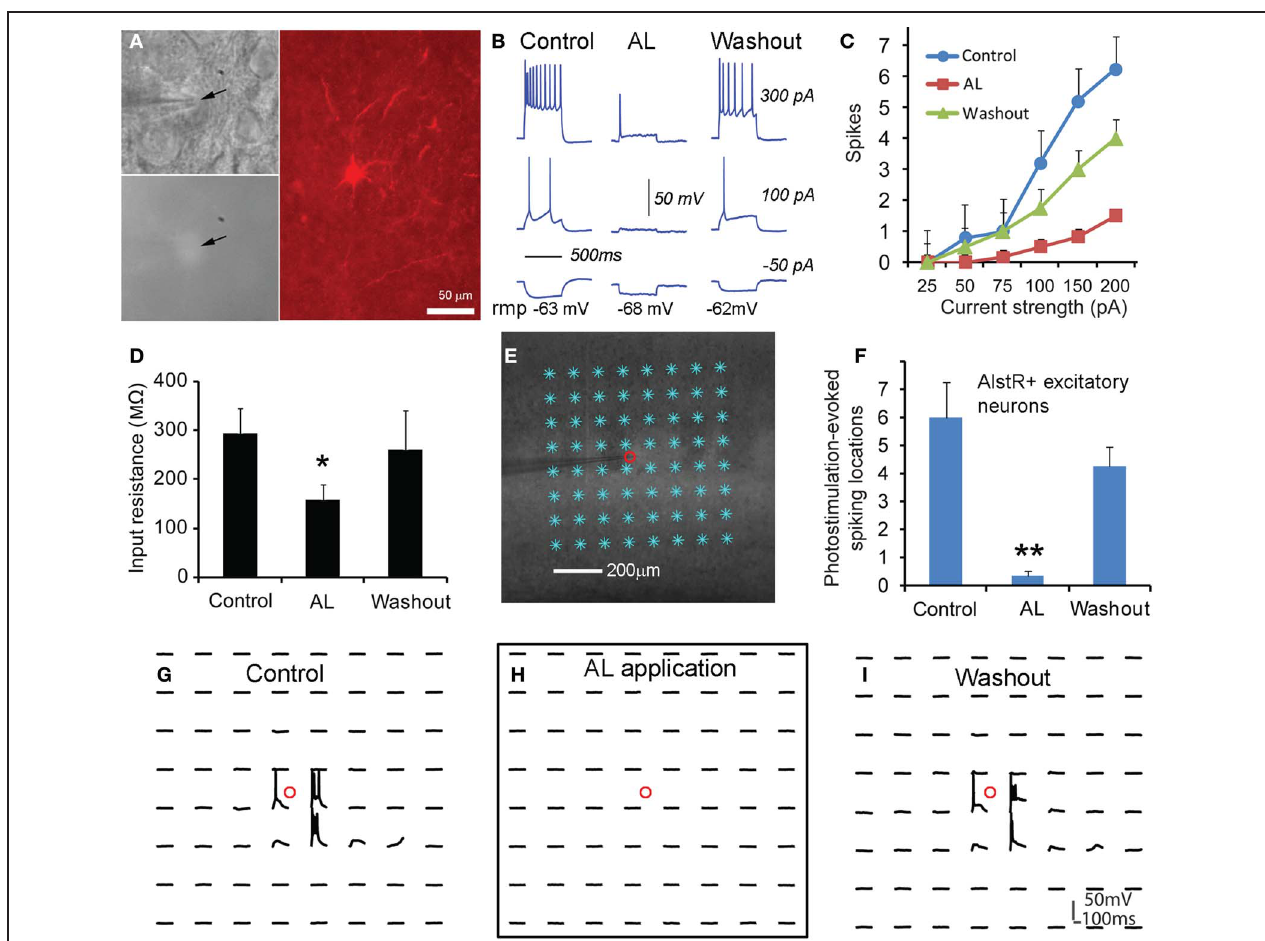
FIGURE 2 | Excitatory neuronal inactivation through the AlstR system. (A) One recorded excitatory neuron expressing GFP and allatostatin receptors in a Emx1-Cre: AlstR cortical slice. AlstR-expressing neurons were targeted based upon their GFP fluorescence (see the arrowheads), and identified post hoc as pyramidal cells based upon their morphology revealed by biocytin staining. (B) The AL application hyperpolarized the cell’s resting membrane potential, reduced the cell’s membrane input resistance, and suppressed action potential firing by intrasomatic current injections. rmp: resting membrane potential. The average hyperpolarization of excitatory neuronal resting membrane potentials was − 2 . 45 ± 0 . 78mV ( N = 6 cells). (C,D) Group data of significantly decreased intrinsic membrane excitability and input resistance in AlstR-expressing (AlstR + ) excitatory